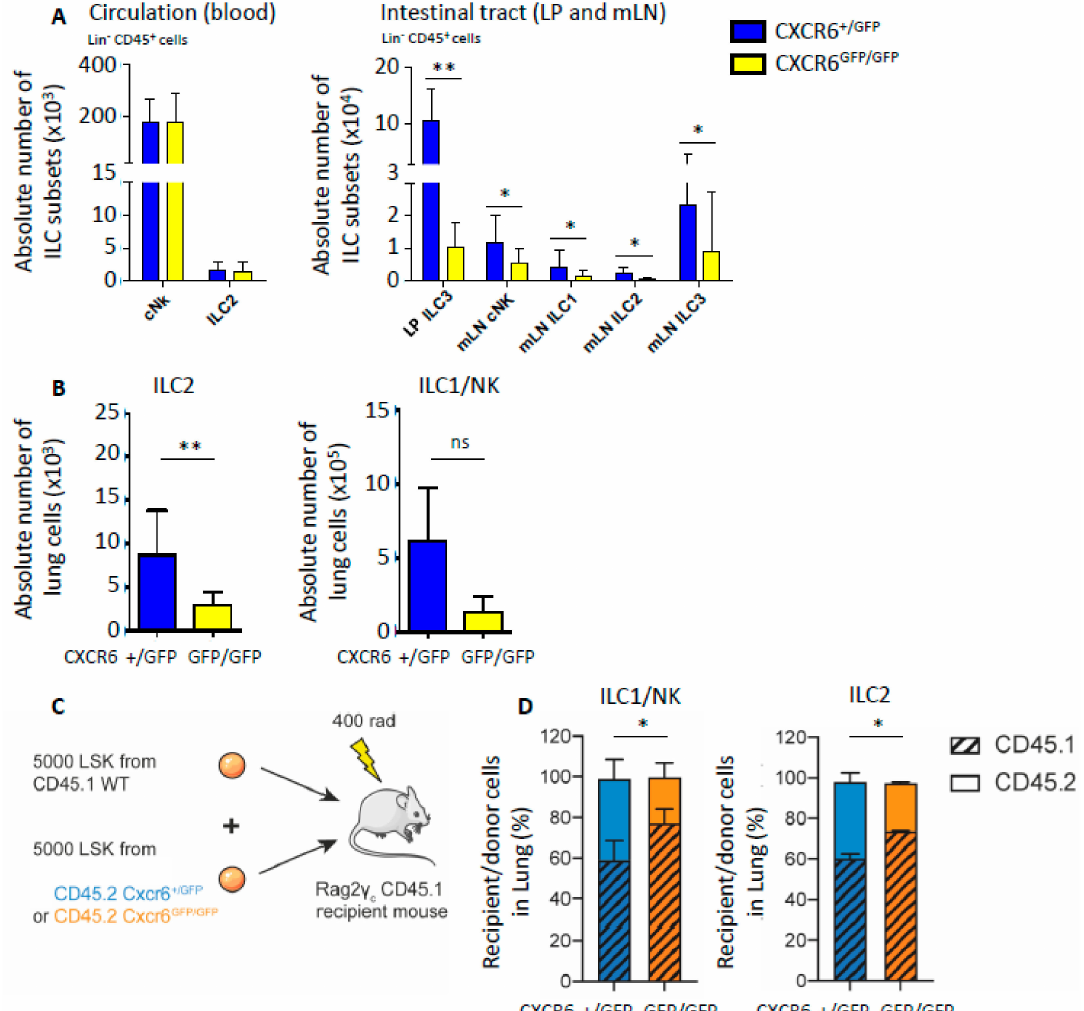
Figure 2. Diverse e ff ects of CXCR6 deficiency on ILC tissue distribution. ( A ) Absolute numbers of di ff erent ILC subsets in CD45 + Lin − (CD3, CD5, CD19, TCR β , TCR γδ , Gr1, Ter119, CD8 α and F4 / 80) blood / Lamina Propria (LP) / mesenteric Lymph Node (mLN) cells from Rag − / − CXCR6 +/ GFP and Rag − / − CXCR6 GFP / GFP mice. ( +/ GFP = 7, GFP / GFP = 7) ( B ) Absolute number of ILC2 (CD45 + Lin − NK1.1 − Sca1 + ) and ILC1 / NK (CD45 + Lin − NK1.1 + NKp46 + ) lung cells from Rag − / − CXCR6 +/ GFP and Rag − / − CXCR6 GFP / GFP mice. ( +/ GFP = 6, GFP / GFP = 4) ( C ) Protocol of competitive experiment, 5000 LSK cells from CD45.1 C57Bl / 6J mice and 5000 LSK cells from CD45.2 Rag − / − CXCR6 +/ GFP or Rag − / − CXCR6 GFP / GFP mice were injected in irradiated (400 rad) Rag − / − γ c − / − CD45.1. ( D ) Repartition of CD45.1 and CD45.2 CXCR6 +/ GFP or CXCR6 GFP / GFP reconstituted cells in ILC1 / NK and ILC2. ( +/ GFP = 4, GFP / GFP = 4) (* p < 0.05 or ** p <